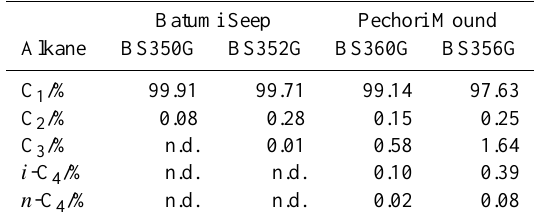
Table 3. Average hydrocarbon composition of the collected gas (%) and the Bernard Ratio ( B f ) ; n.d.=not detected. Station, Core